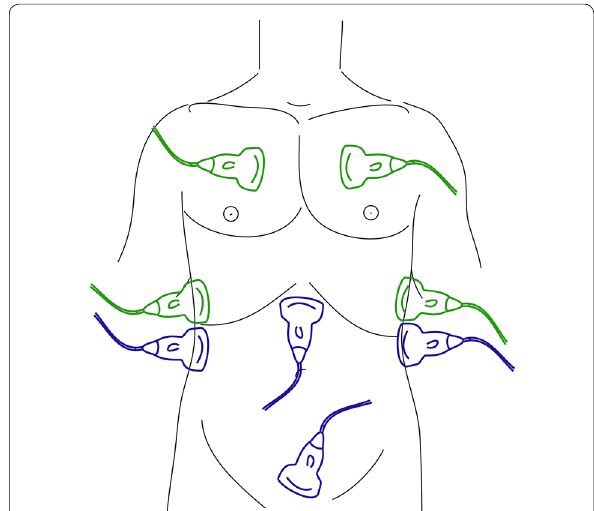
Fig. 1 The FAST and eFAST exam. The blue probes illustrate the scanning positions of the FAST exam. The green probes illustrate the scanning positions of the extended FAST exam assessing for pneu- mothorax and